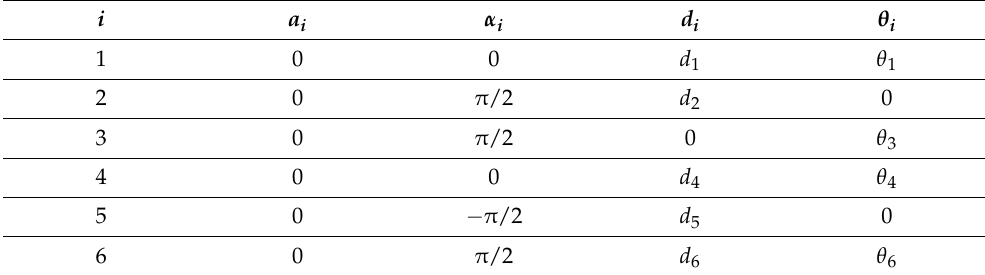
Figure 3. D–H model diagram of the two-wheeled stair climbing robot with a “4R+2P” pattern. Table 1. D–H model